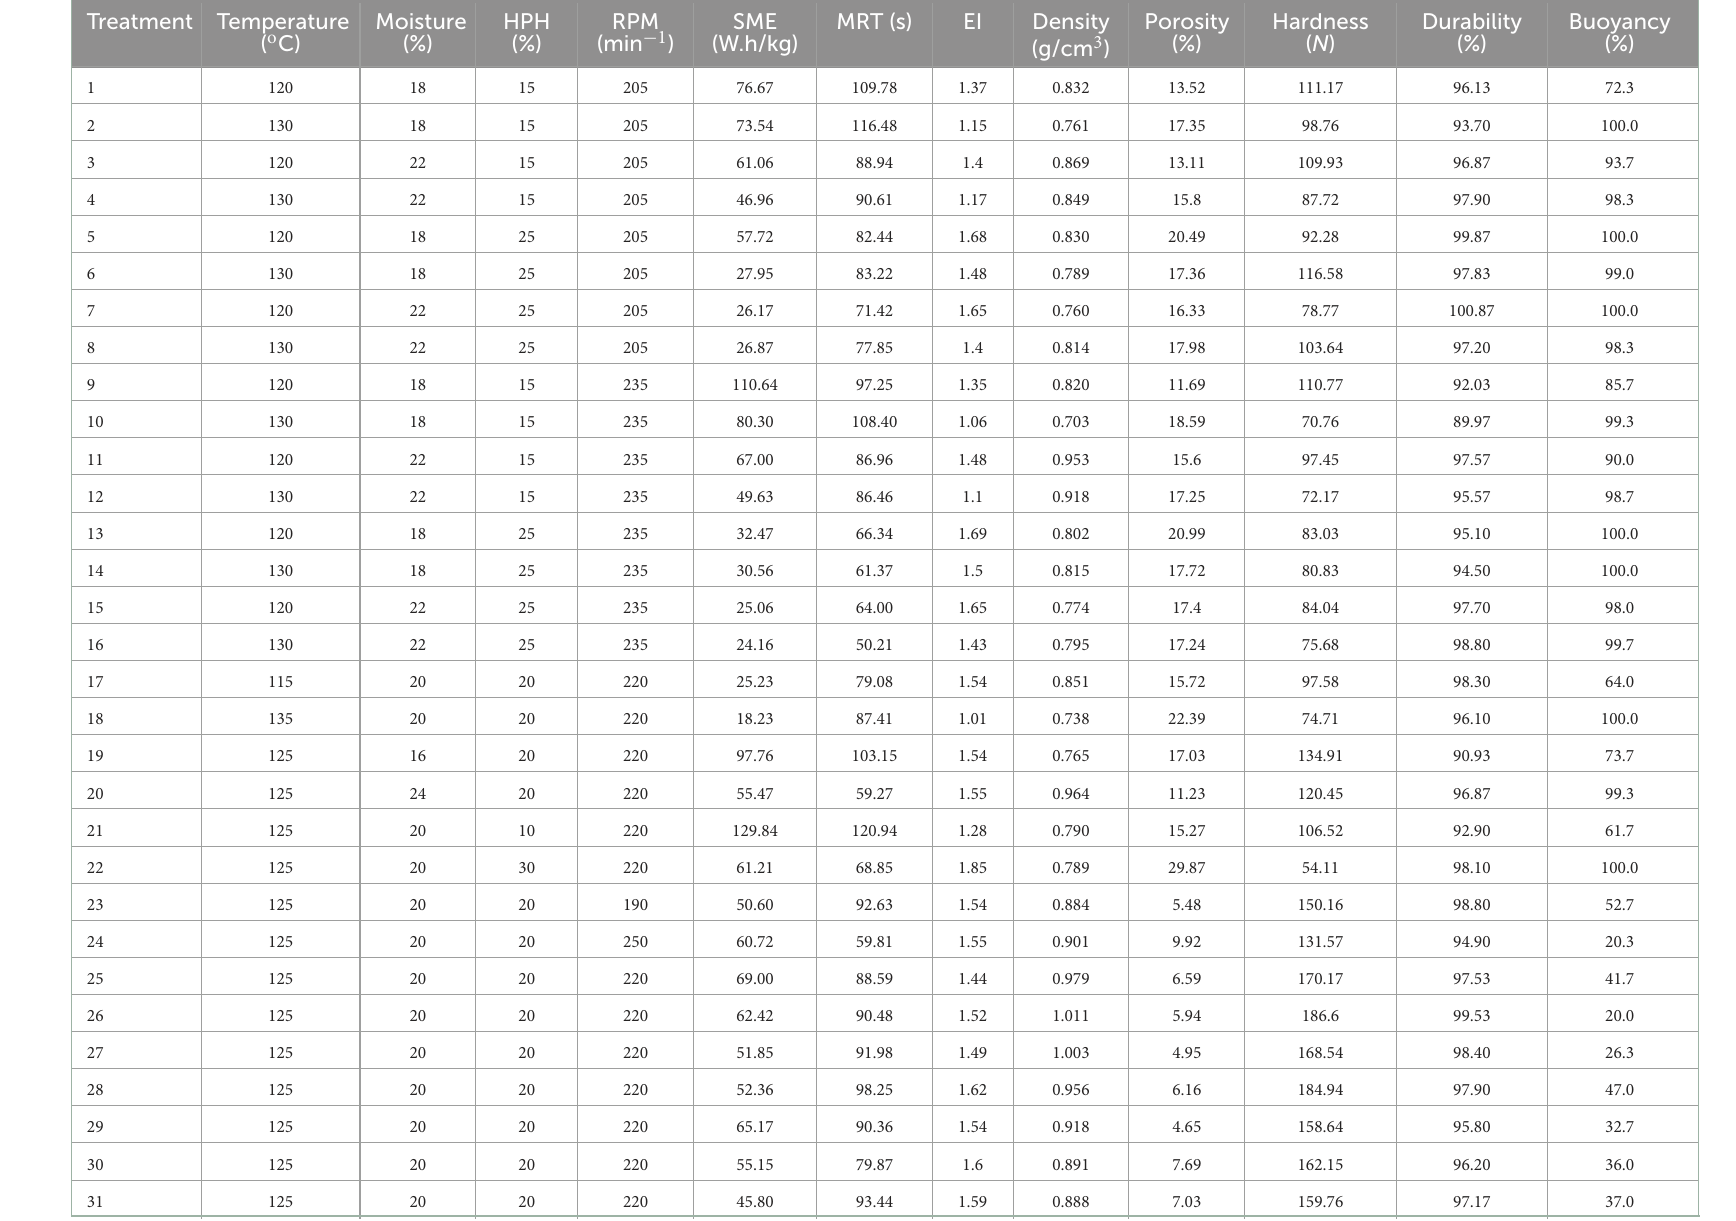
TABLE 3 Experimental design based on temperature, moisture, hydrolyzed protein flour (HPH) and screw speed